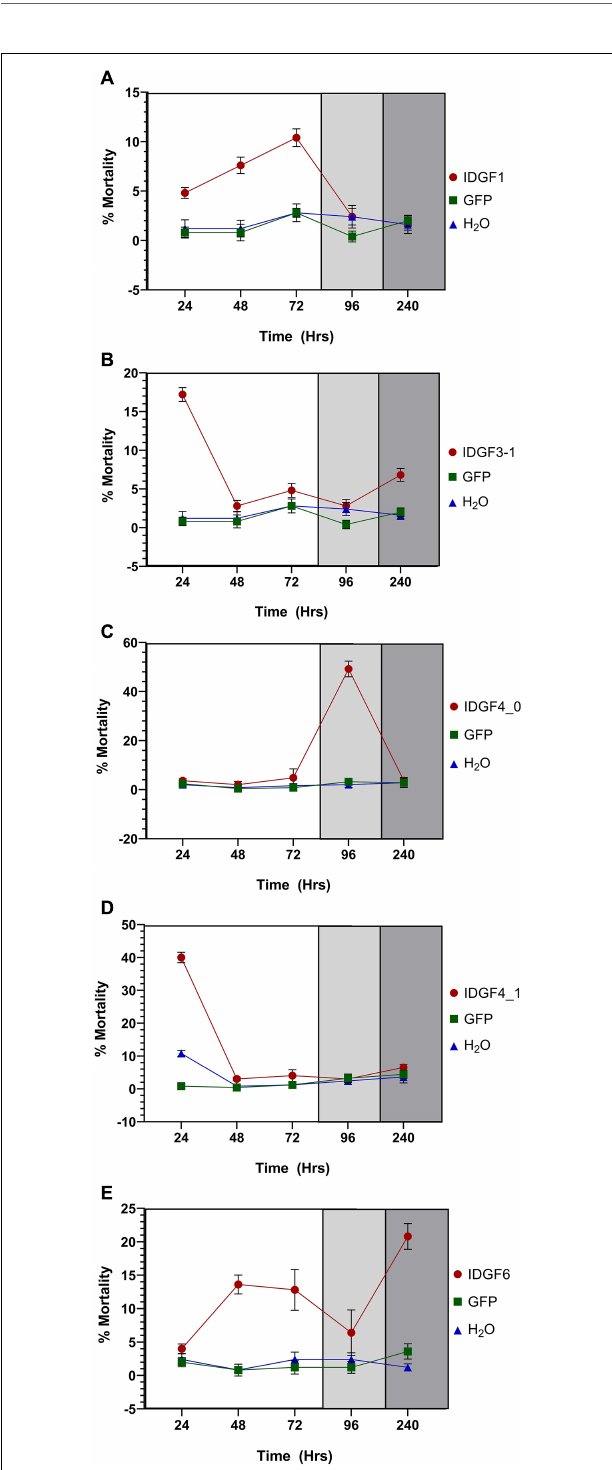
FIGURE 7 | Mortality rate (%) of Z. cucurbitae at different developmental stages after being artificially fed with dsGFP or DEPC or dsRNA of IDGFs. The letters (A–E) represents IDGF1 , IDGF3_1 , IDGF4_0 , IDGF4_1 , and IDGF6 . The white portion represent larval stages, light gray indicates pupal stage, and dark gray indicates adult stage of Z . cucurbitae . The values are presented as the mean ( ± SE) of five biological replications (50 insects were used per replicate). Treatments were compared using one-way ANOVA (Turkey’s test, p <